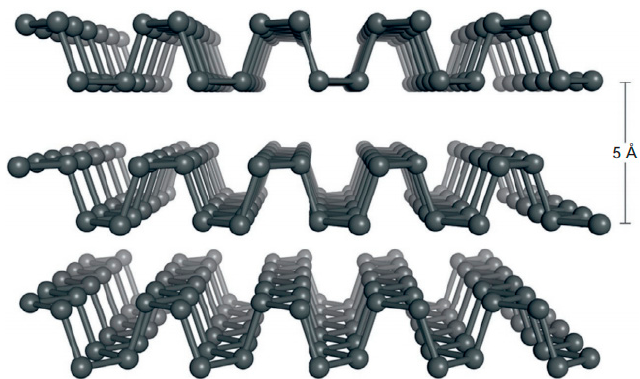
Figure 9. The layered and anisotropic crystal structure of elemental black phosphorus. (Reprinted with permission from [41]. Copyright (2015), Elsevier.)